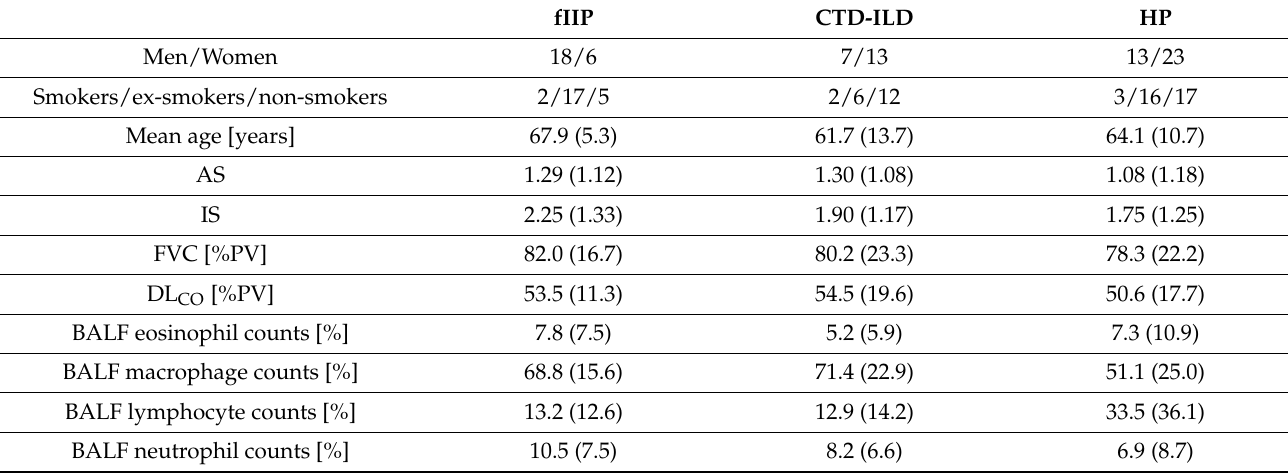
Table 2. Demographic parameters, lung functions, and BALF differential cell counts of patients with different types of IIPs.